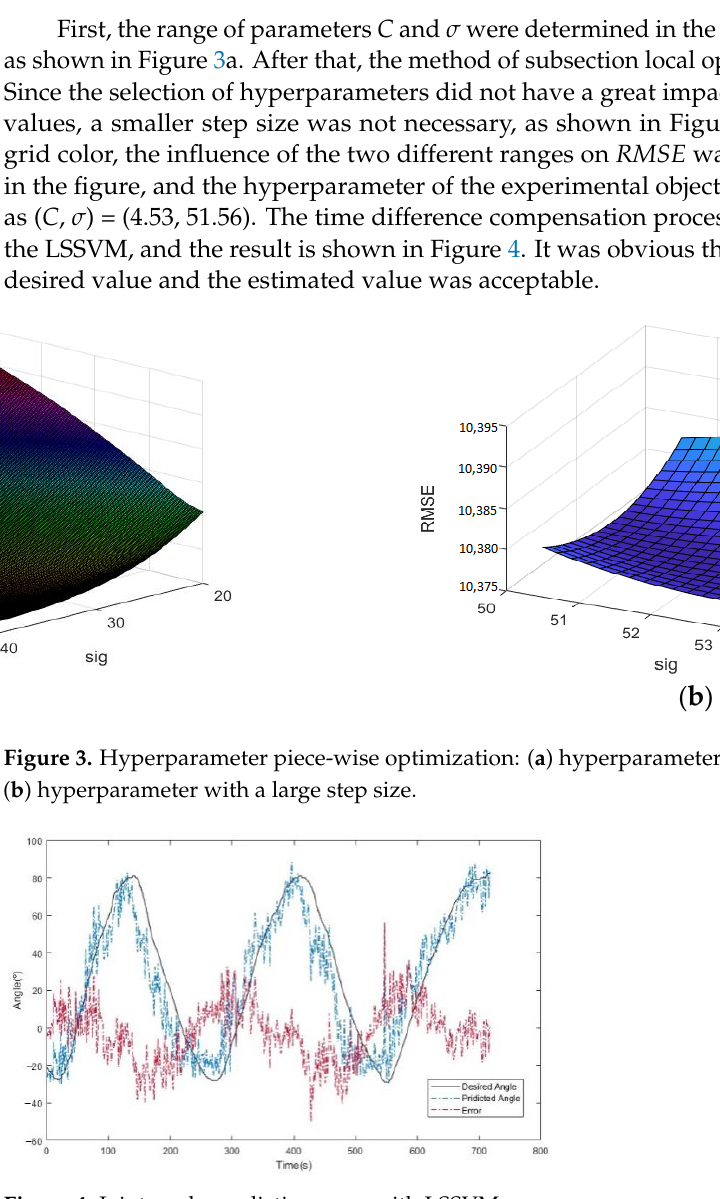
Figure 4. Joint angle prediction error with LSSVM.